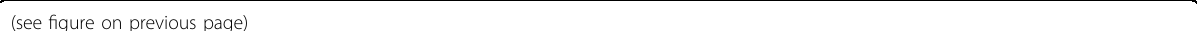
(see fi gure on previous page) Fig. 3 Participant Outcomes. A , B Time series of individual participant outcomes for primary (YBOCS) and secondary (MADRS) variables. Within each graph, group-average trajectory is represented by a loess smoothed curve (white) ± 1 standard error (grey). Baseline measurement denoted by green outline, recovery phase by yellow outline and blinded phase by red outline. C , D Boxplots of YBOCS and MADRS change by randomised group (on = green versus off = red) during the blinded phase. E , F Raincloud plots of YBOCS and MADRS change across the full trial. Raincloud plots made with code provided by Allen et al. 75 . and van Langen 76 . G , H Trajectories of the participants by group (active versus sham) in the blinded phase. There were fi ve participants in the active group and four in the sham